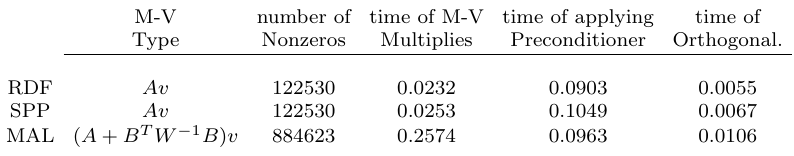
Table 2. Execution average times of single iterative process for steady Oseen problems (Q2-Q1 FEM, 64 × 64 uniform grid), ν = 0 . 001 and the parameter values are respectively found